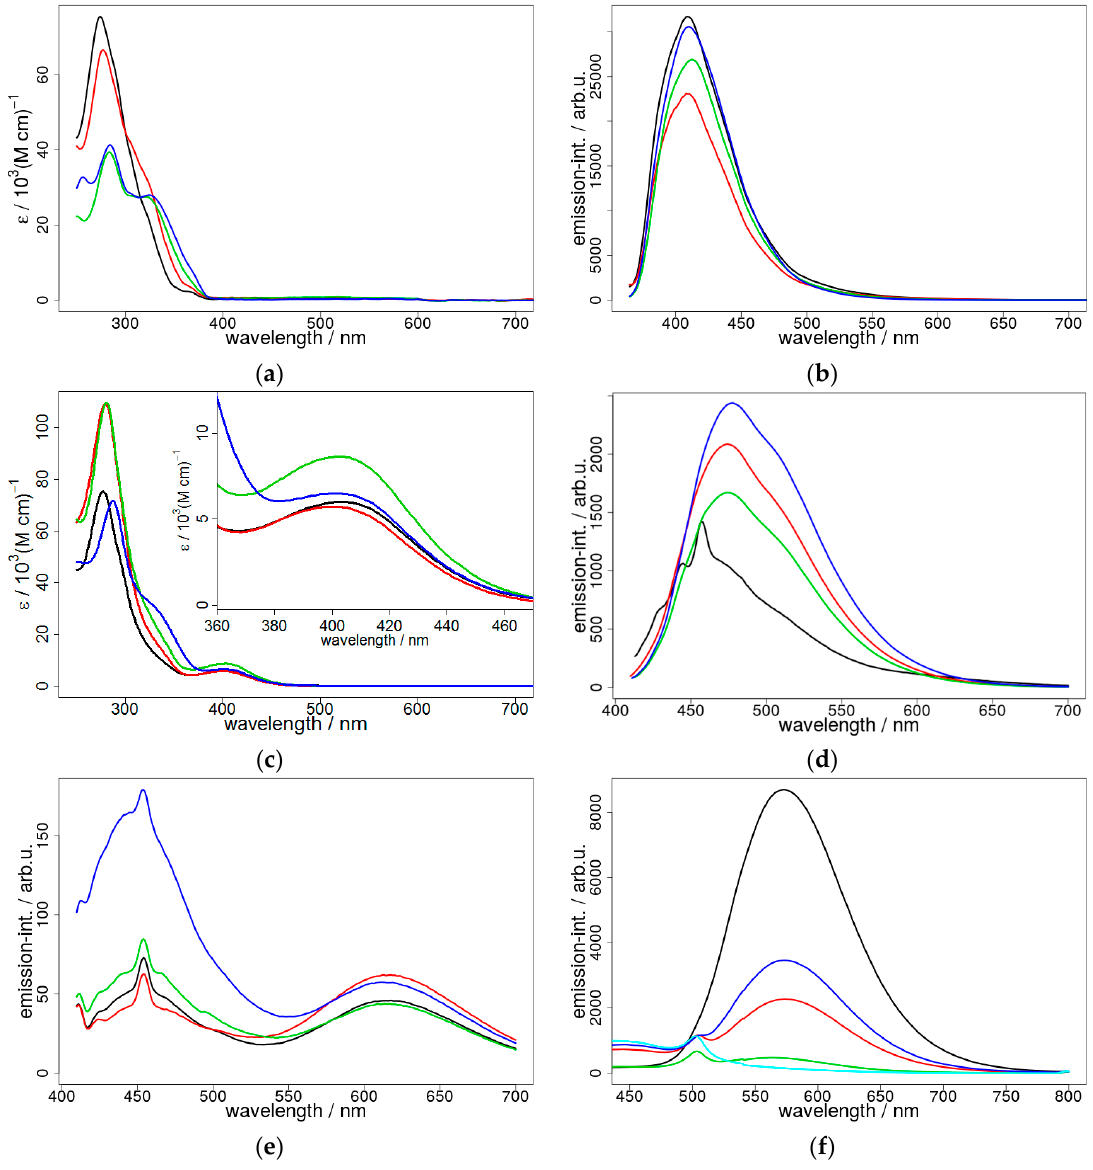
Figure 6. Absorption and emission spectra of the ligands L1 (black), L2 (red), L3 (green) and L4 (blue) ( a , b ) in dichloromethane and of the complexes C1 (black), C2 (red), C3 (green) and C4 (blue) ( c , d ) in acetonitrile solution. In panel ( e ) the emission spectra of C1 – C4 (all measured with an optical density of 0.1 at λ exc = 400 nm) are also presented in dichloromethane solution for comparison. Emission spectra were measured at room temperature under argon atmosphere. The emission of the solid samples C1 – C4 are depicted in panel ( f ). The light blue line represents the emission of the blank test (only the sample holder without any sample).